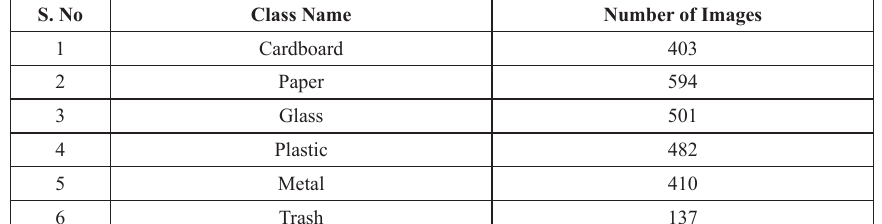
Table 2. Distribution of data in TrashNet